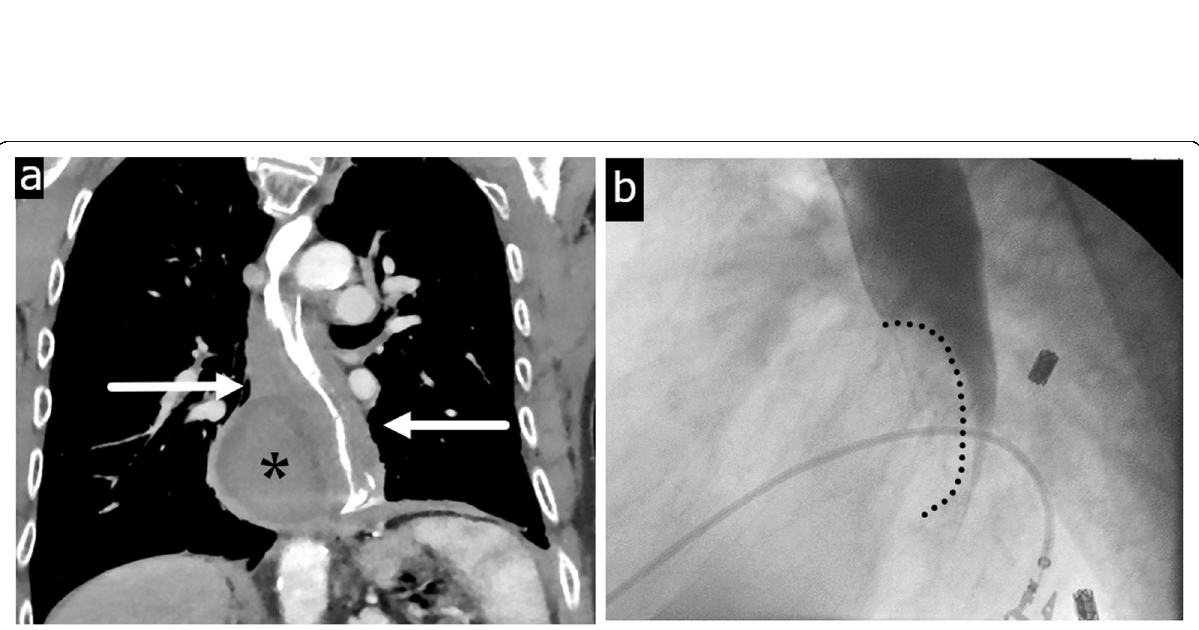
Fig. 7 Esophageal obstruction with food bolus impaction ( a ) and therapeutic foreign body/prosthesis ( b ). a An 83-year-old demented male with chest pain during meal. Sagittal CT image shows a large chunk of food impaction in the mid to lower esophagus (dotted area). The upper esophagus is mildly dilated with an air-fluid level. b A 71-year-old male with history of laryngectomy for laryngeal cancer with a tracheoesophageal voice prosthesis which may mimic a foreign body. Axial CT image shows a small tubular shaped radiopaque device (arrow) between the tracheostomy (arrowhead) and the upper esophagus (asterisk). There is a tracheostomy defect and associated large skin defect anteriorly (bidirectional arrow)